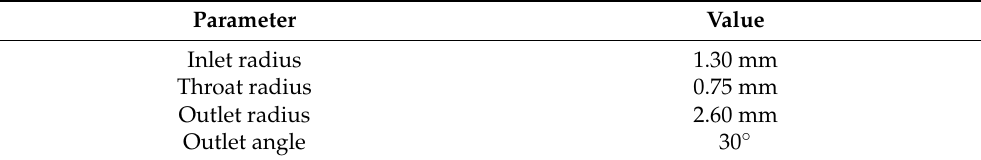
Figure 2. Structure of the de Laval nozzle. The three straight arrows are the inlet, throat and outlet from left to right, where A * is the cross-sectional area of throat and the speed is 1 Ma at this point. The only curved arrow indicates the outlet angle θ . Table 1. Design parameters of the de Laval nozzle.